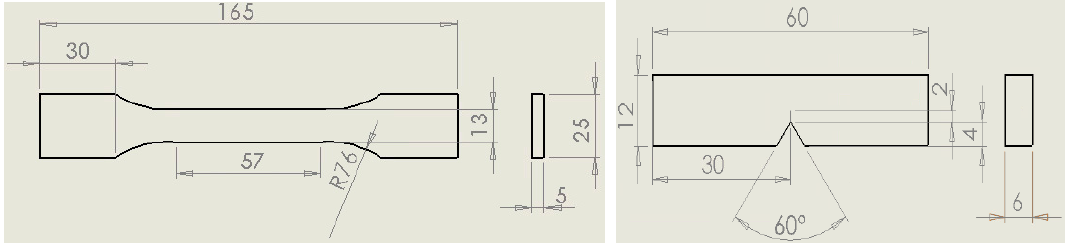
Figure 12. TYPE I tensile ( left ) and SENB ( right ) test specimen dimensions. All dimensions are in millimetres.